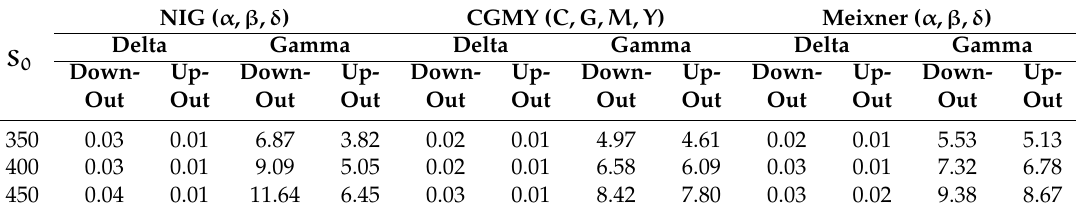
Table 4. Change of Delta and Gamma over Stock price change.